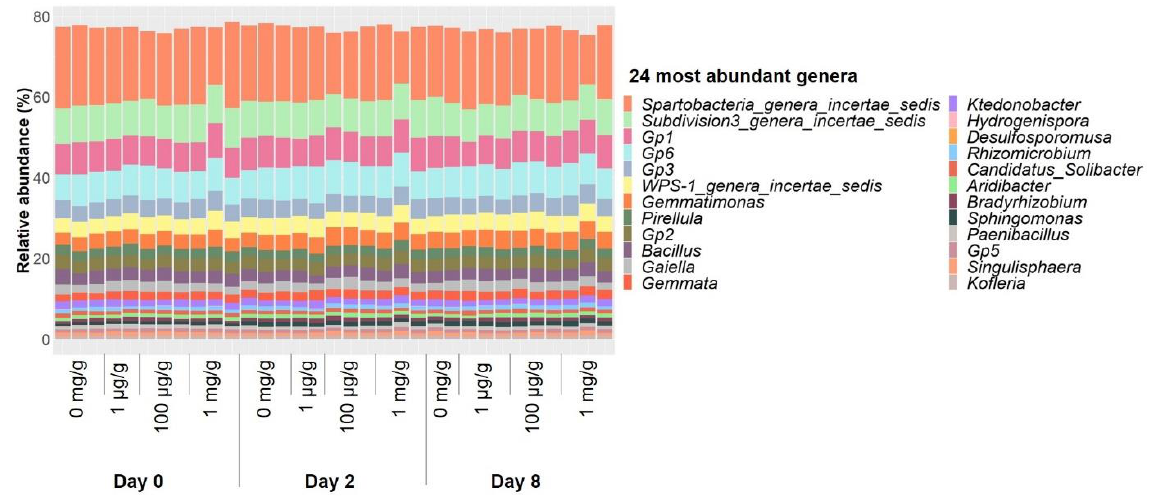
Figure 5. Relative abundances of the 24 most abundant genera in the total communities from nonpolluted soil microcosms or microcosms with 1 µg/g, 100 µg/g or 1 mg/g of gentamicin. Triplicates are plotted individually.